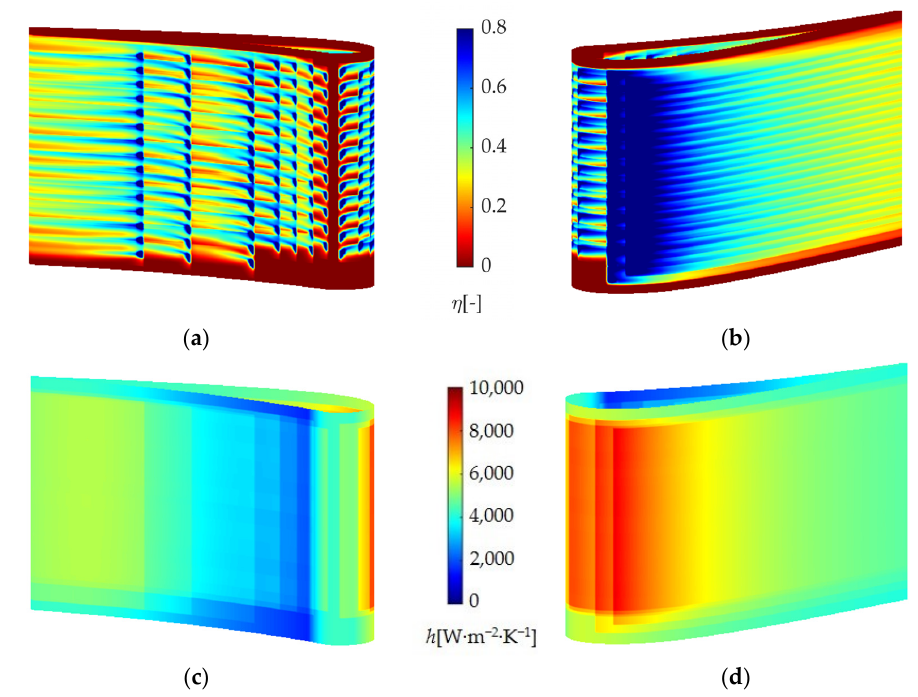
Figure 4. Boundary conditions generated by the data ‐ driven method: ( a ) Film effectiveness on pressure surface ( ‐ ); ( b ) Film effectiveness on suction surface ( ‐ ); ( c ) HTC on pressure surface (W ∙ m − 2 ∙ K − 1 ); ( d ) HTC on suction surface (W ∙ m − 2 ∙ K − 1 ).